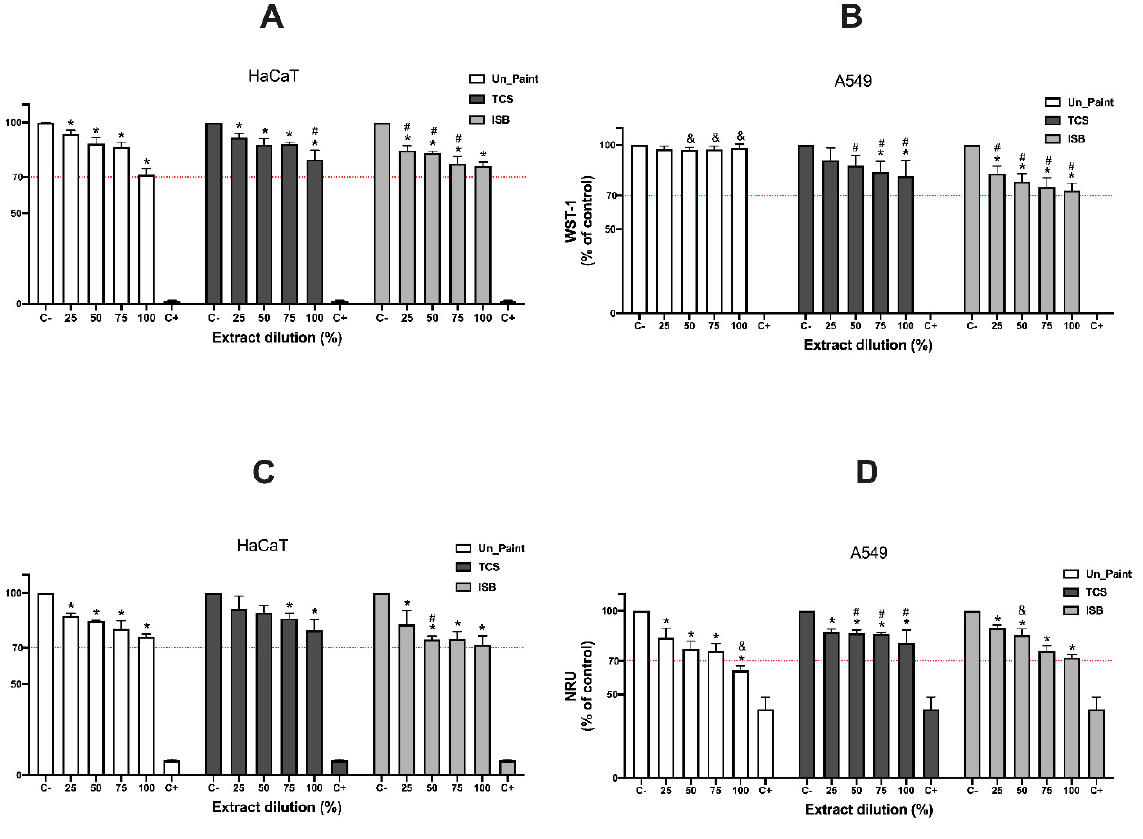
Figure 4. Results of WST-1 ( A , B ), NRU ( C , D ) and LDH ( E , F ) assays, with HaCaT and A549 cells, after 24 h incubation with the extracts (in the x axis) of the samples of Un_Paint, TCS and ISB extracts at concentration of 25, 50, 75 and 100%. C- negative control (assay medium), C+ positive control (Triton X-100 solution (1%) for WST-1 and LDH or SLS 0.2 mg/mL for NRU). The red lines represent the defined thresholds of acceptable values for each parameter, 70% for cellular viability and 30% for LDH leakage. The values are expressed as mean ± standard deviation. The statistical significance of the extracts compared to C- is represented by *, and the statistical differences compared to Un_Paint are represented by # (One-way ANOVA; p < 0.05). The statistical significance of the extract on A549 cells compared to the same extract, in the same concentration, on HaCaT cells is represented by & (Two-way ANOVA; p < 0.05). A similar trend was found with NRU assays; however, only IBS presented significant decreases for all tested concentrations. For TCS, only the higher concentrations (75% and 100%) were significantly different from the negative control.